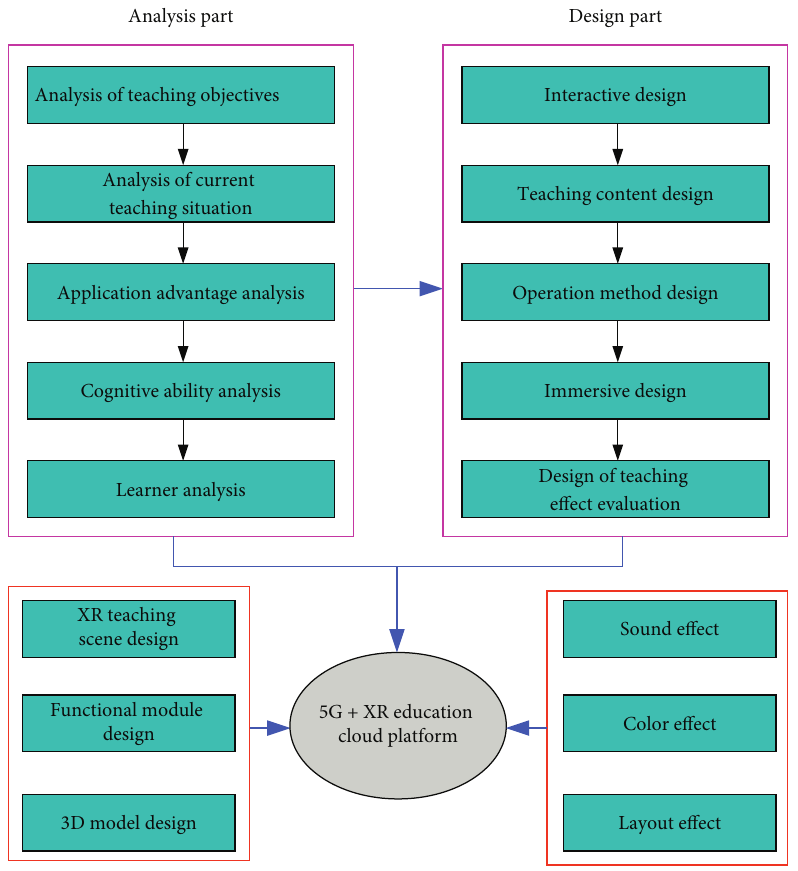
Figure 8: Schematic diagram of immersive virtual teaching method